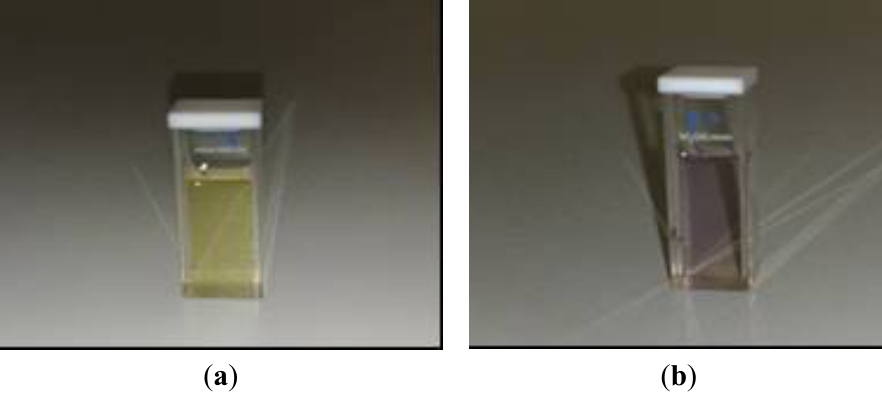
Figure 5. The change of color for OIC2MS in chloroform upon sunlight exposure. ( a ) Pale yellow solution under dark conditions and ( b ) pale violet solution after light exposure for 2 min at room temperature.